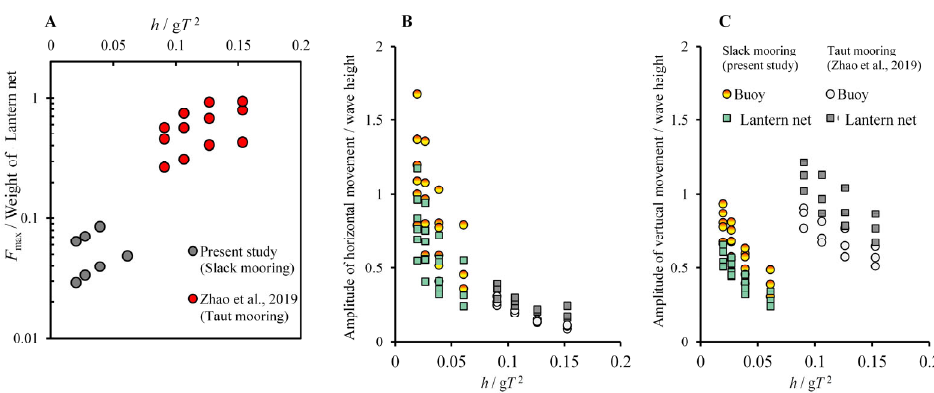
Figure 8. Relationships between ( A ) F max /weight of lantern nets, ( B ) amplitude of horizontal movement/wave height, ( C ) amplitude of vertical movement/wave height and h/gT 2 (h: water depth, g : acceleration of gravity, T : wave period).